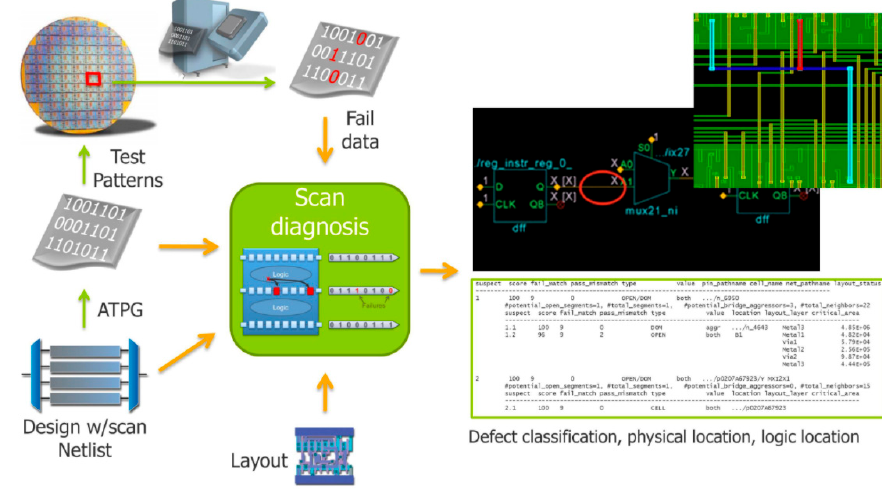
Figure 18. ATPG flow of fault identification.